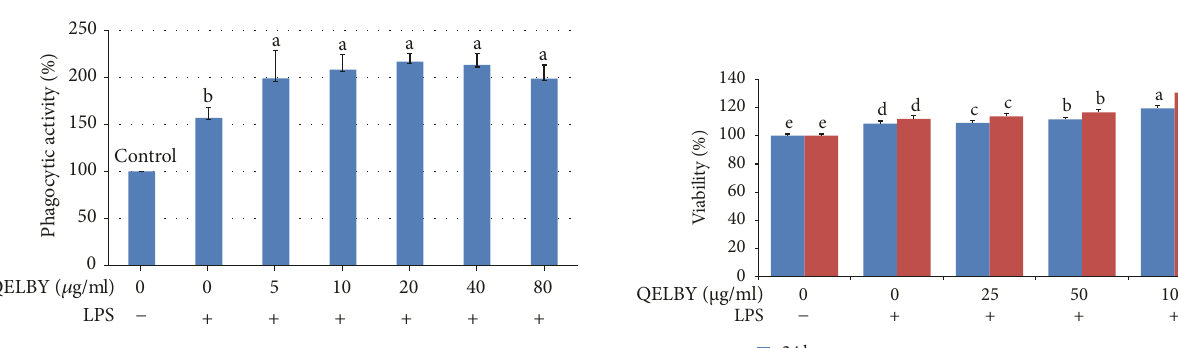
Figure 10: Evaluation of natural killer cell activity. Effector cell (isolated spleen cell) and target cells (YAC-I) were cultured at an effector : target ratio of 10 :1 in RPMI 1640 media. The culturing media were prepared by mixing with different amount of suspended layer from the RPMI 1640 media mixed with 1% of QELBY powder and left for 24 hours. NK cell activity was assessed using CCK-8 assay to measure cell cytotoxicity against YAC-I cells. The results are expressed as mean ± SD (𝑛 = 5) . Bars with different superscript are significantly different at 𝑝 < 0.05 .